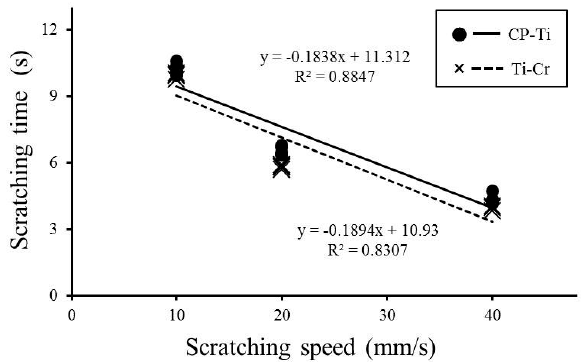
Figure 5. Linear regression between the scratching time and scratching speed for both commercially pure titanium (CP-Ti) and titanium alloys containing 20 mass% chromium (Ti-20Cr).